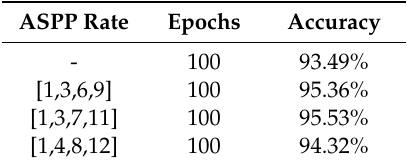
Table 6. Comparison between ASPP at di ff erent atrous